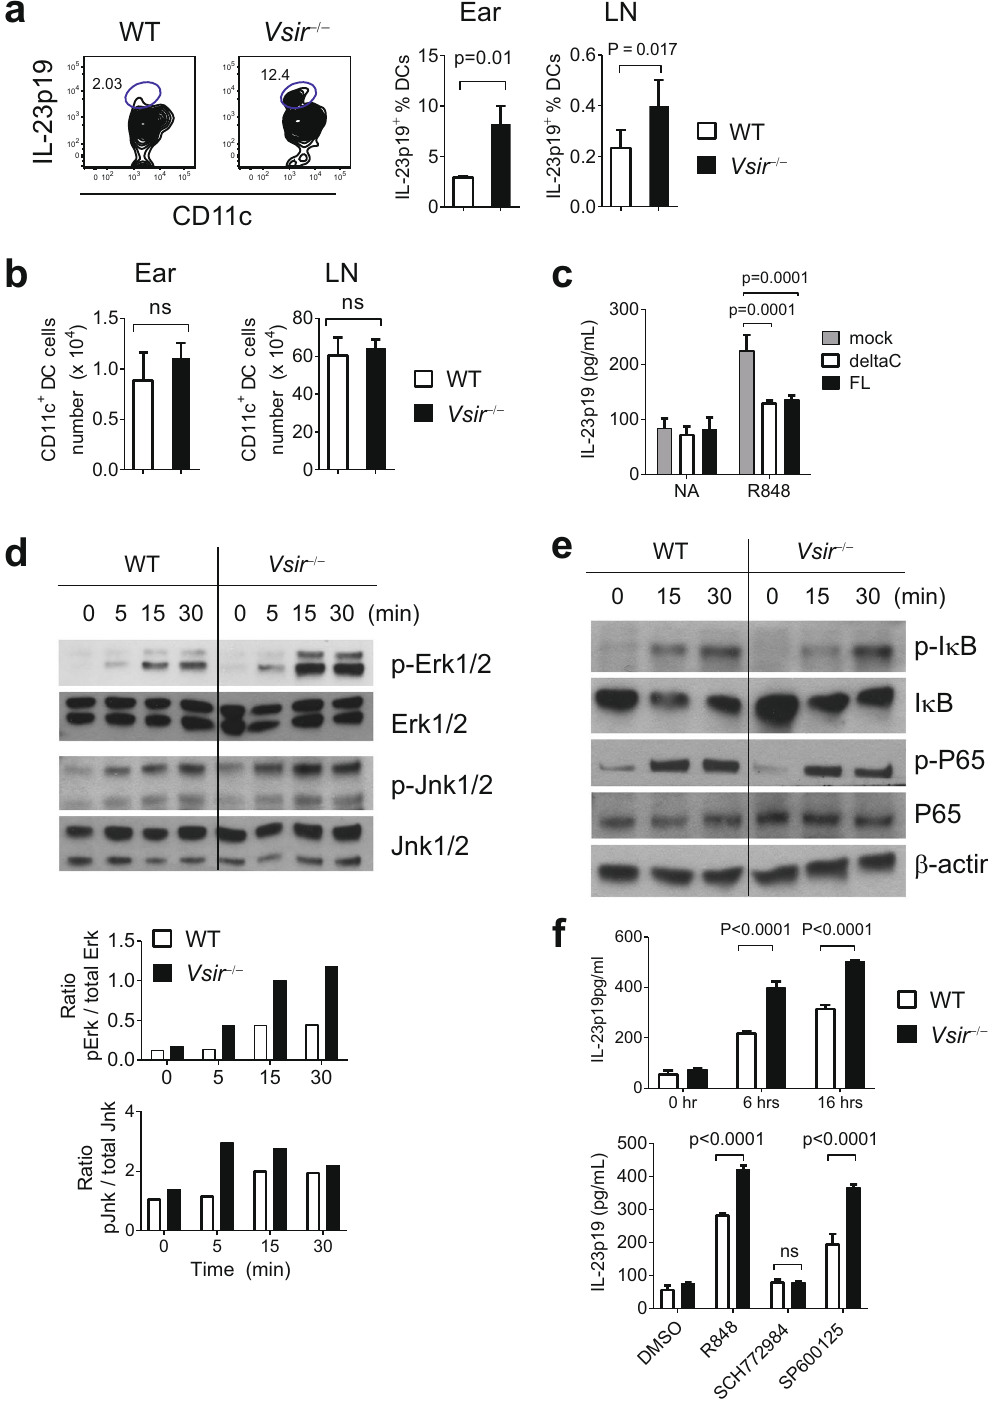
Figure 5. VISTA negatively regulates IMQ-induced activation of DCs and the production of IL-23. WT and Vsir − / − mice were treated on ears with 3.5% IMQ for 3 days. Cells from ear tissues and the ear-draining cervical LNs were harvested. Cells were stimulated with PMA and Ionomycin in vitro for 3 hrs. The expression of IL-23p19 in CD11c + DCs was examined by flow cytometry. The percentages of IL-23p19-expressing DCs were quantified and shown as mean ± SEM (n = 6) in ( a ). The number of total CD11c + DCs from ear tissue and draining LN is shown as mean ± SEM (n = 5) in ( b ). To determine whether ectopic expression of VISTA suppresses TLR7-induced IL-23 production, Vsir − / − BM-derived DC were transduced with lentivirus expressing full-length (FL), or mutant VISTA lacking the cytoplasmic tail (deltaC), or GFP control protein. After culture with GM-CSF (20 ng/ml) for 7 days, cells were stimulated with R848 (5 μ g/ml) for 7 hrs. Culture supernatant was harvested and secreted IL-23p19/p40 was examined by ELISA ( c ). To examine TLR7 signaling in DCs, CD11c + DCs were purified from the spleens of naïve Rag1 − / − and Vsir − / − Rag1 − / − mice, and